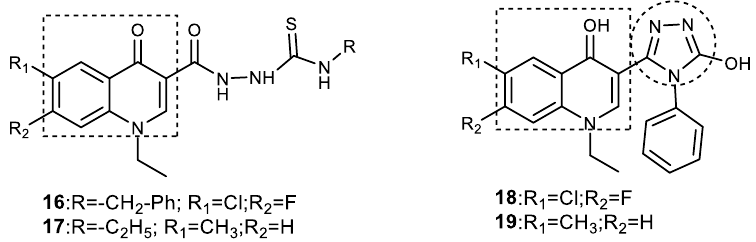
Figure 12. Chemical structures of quinoline – 1,2,3-triazole conjugates.